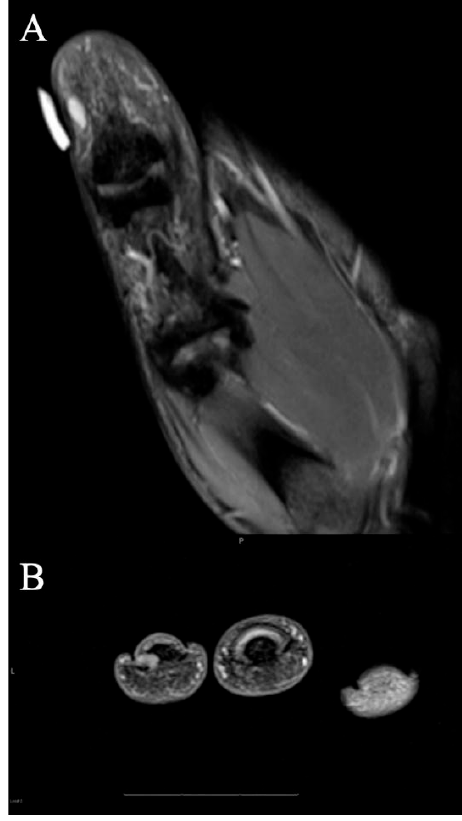
Figure 7. Glomus tumor. ( A ) Coronal fat ‐ suppressed PD MRI shows a small 5 mm T2 hyperintense mass abutting the radial cortex of the thumb distal phalanx, consistent with glomus tumor that was subsequently excised. Note good correlation with overlying marker indicating site of pain. ( B ) T2 ‐ weighted axial image at the level of the paronychial folds that show a hyperintense mass just adjacent to the distal phalanx. The mass was excised and found to be a glomus tumor.